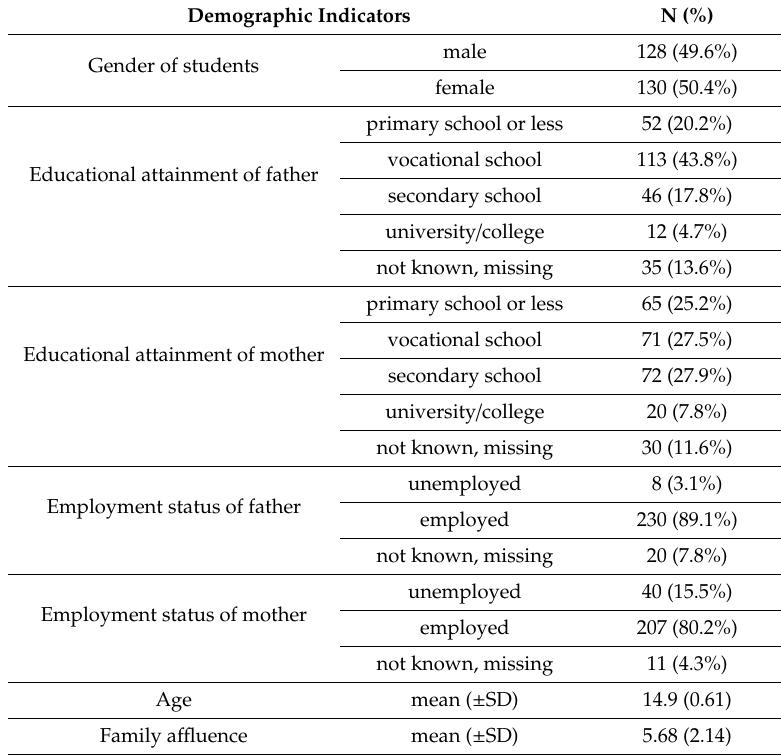
Table 1. Demographic and socioeconomic characteristics of the study population (N =